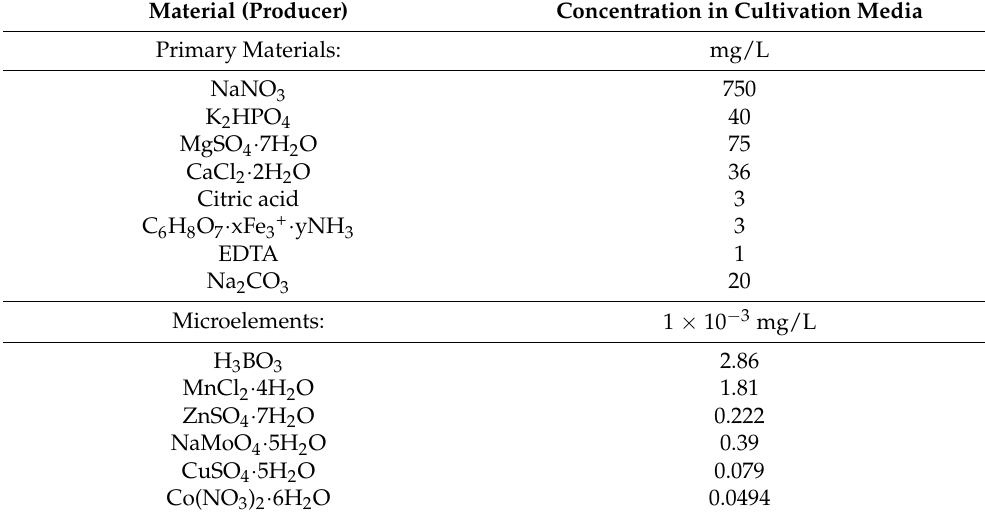
Table 1. Composition of nutrient medium